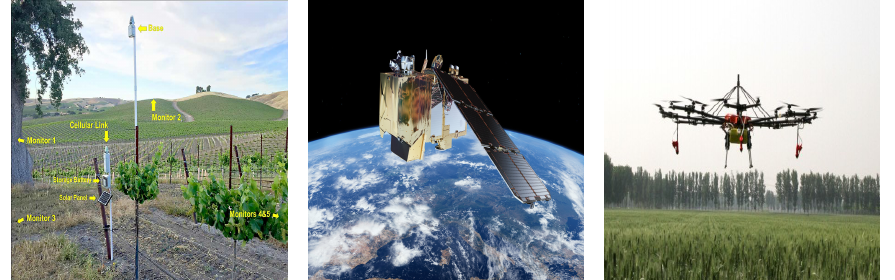
Figure 9. From left to right: sensors mounted on ground-based platforms to test vineyard stress (https://www.goodfruit.com/using-sensors-to-test-vineyard-stress/, accessed on 9 December 2021), Sentinel2 satellites (https://www.esa.int, accessed on 3 November 2021), and unmanned aerial vehicles (UAVs: https://precisionagricultu.re/12-potential-uses-for-uas-in-agriculture/, accessed on 9 December